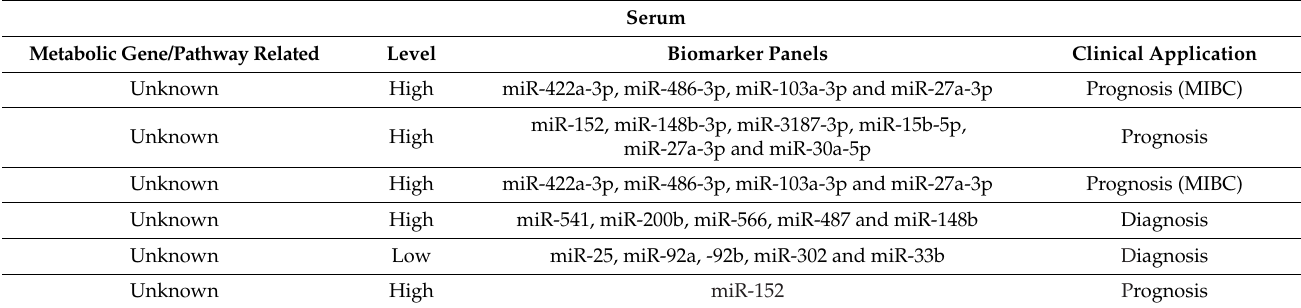
Table 5. miRNA markers found in serum patient cohorts with BC.